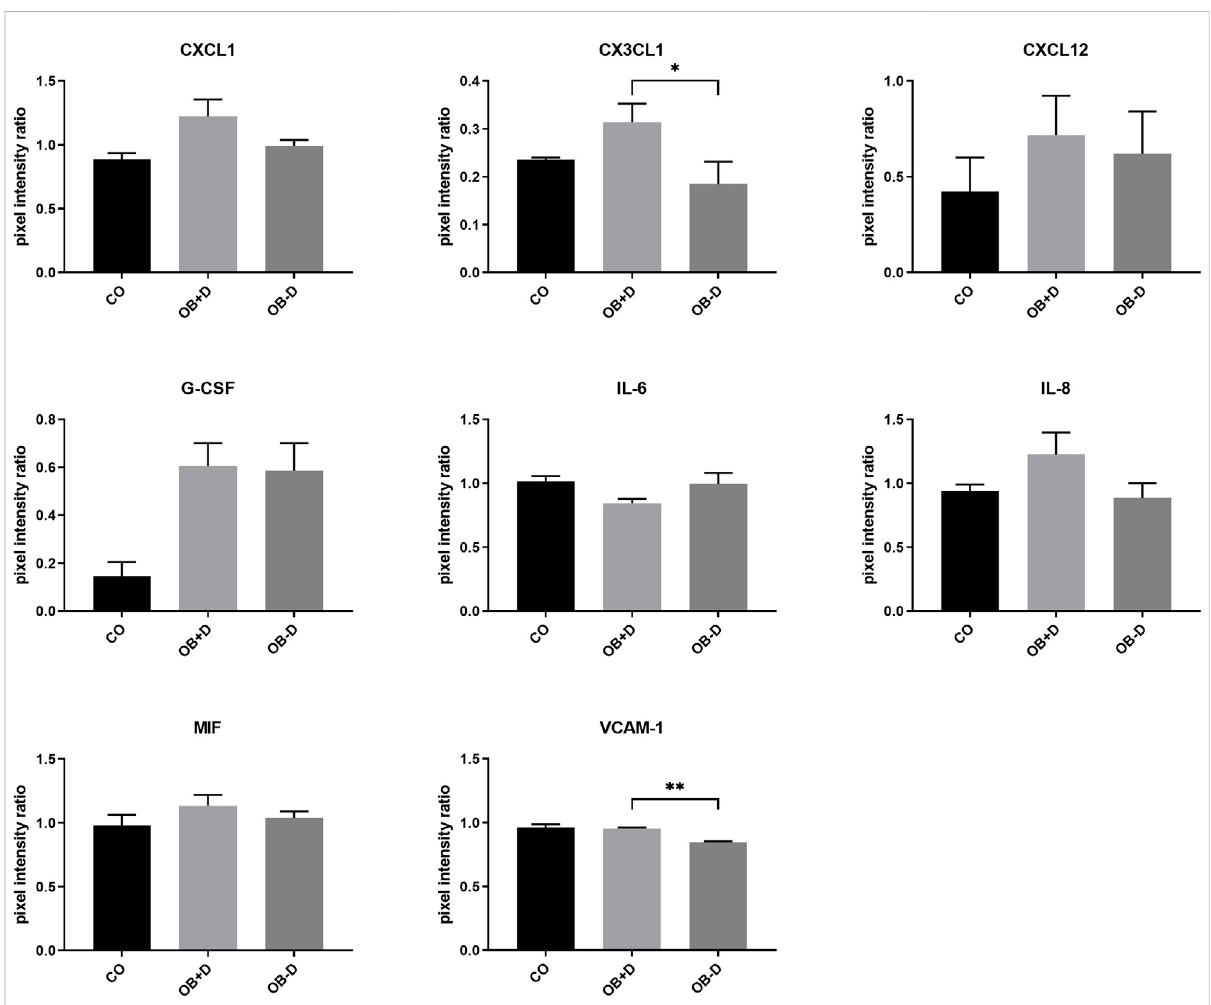
FIGURE 9 Secretionofosteoclastogenesis-relatedproteins byJPCs cultured for15 days withcontrol medium (CO)andosteogenic medium with (OB+D) and without (OB − D) dexa. Protein expression was examined by detection of soluble factors secreted into culture supernatants using proteome pro fi ler arrays and analysis of pixel intensities of detected signals using ImageJ software. Pixel intensity ratio mean ± SEM values were calculated by normalizationtointernalcontrolsandcomparedusingone-wayANOVAandTukey ’ smultiplecomparisontest(n=3,*= p < 0.05,**= p <